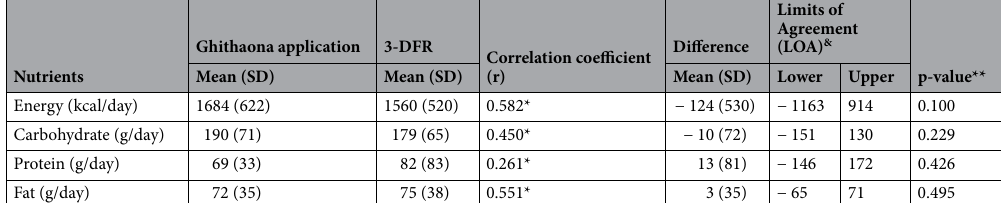
Table 2. Differences in nutrient intakes recorded by the 3-DFR and Ghithaona application. SD = Standard Deviation. *p ≤ 0.05 using Pearson correlation. **p-value is the significance level between two methods using Wilcoxon signed-rank test (skewed data for energy, protein, and fat) or paired t -tests (normally distributed data for carbohydrate). & Lower and upper Limits of Agreement (LOA) (mean difference ± 1.96 SD).